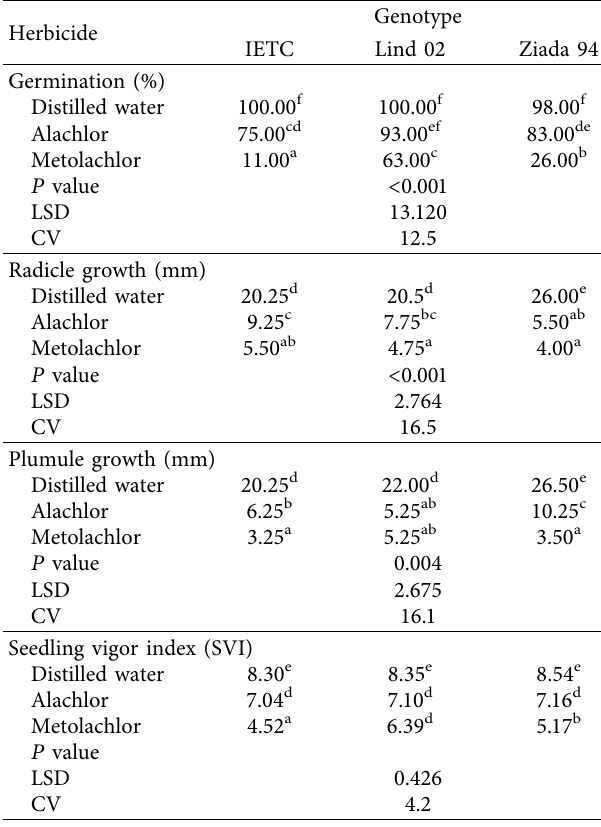
Table 1: The effect of preemergence herbicides on germination and early seedling growth of sesame